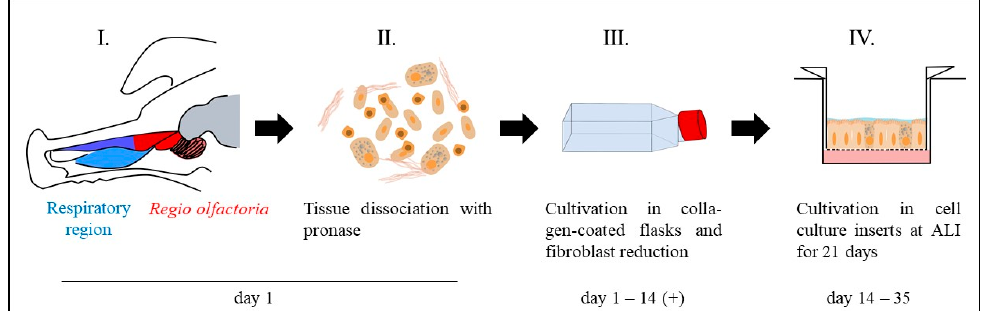
Figure 1. Workflow for primary cell isolation and cultivation under air–liquid interface (ALI) (blue) (I.). Single cells were obtained by pronase digestion of the mucosa explants (II.). Single cells were cultivated in collagen-coated T75 cell culture flasks (III.). To reduce fibroblast overgrowth, the